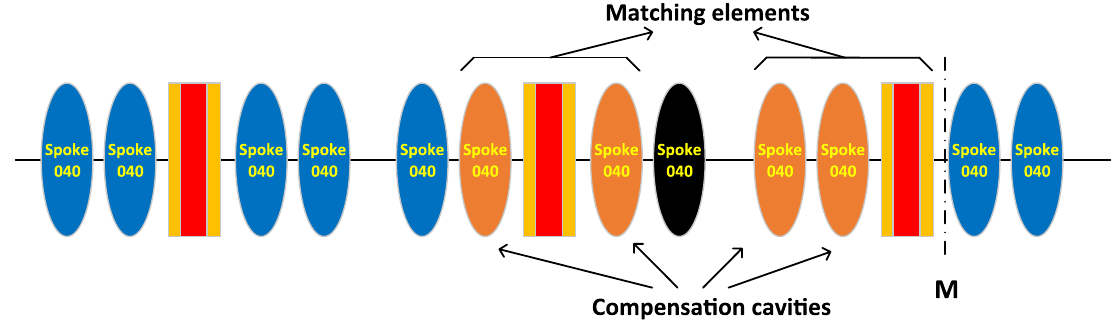
FIG. 30. LocalcompensationforacavityfailureinthemiddleSpoke040section.(Theblueellipsesstandforcavities,theredsquaresfor solenoids, the black ellipse for the failed cavity, and the orange ellipses for major compensation cavities. M stands for matching